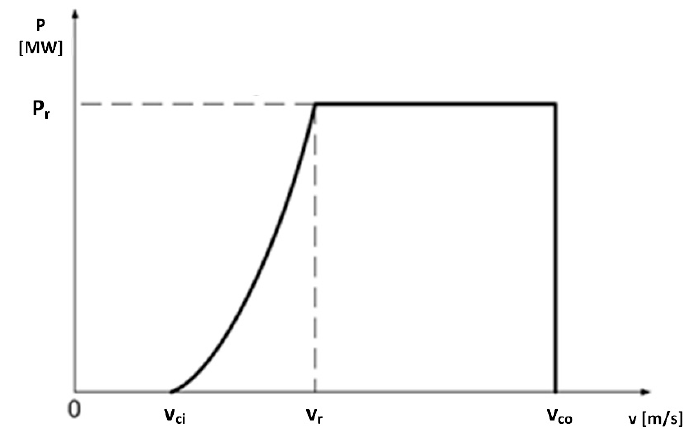
Figure 4. Production characteristic of a wind power plant (WPP). v ci : cut-in wind speed; v r : rated wind speed; v co : cut-out wind speed; P r : rated electrical output power of WPP.